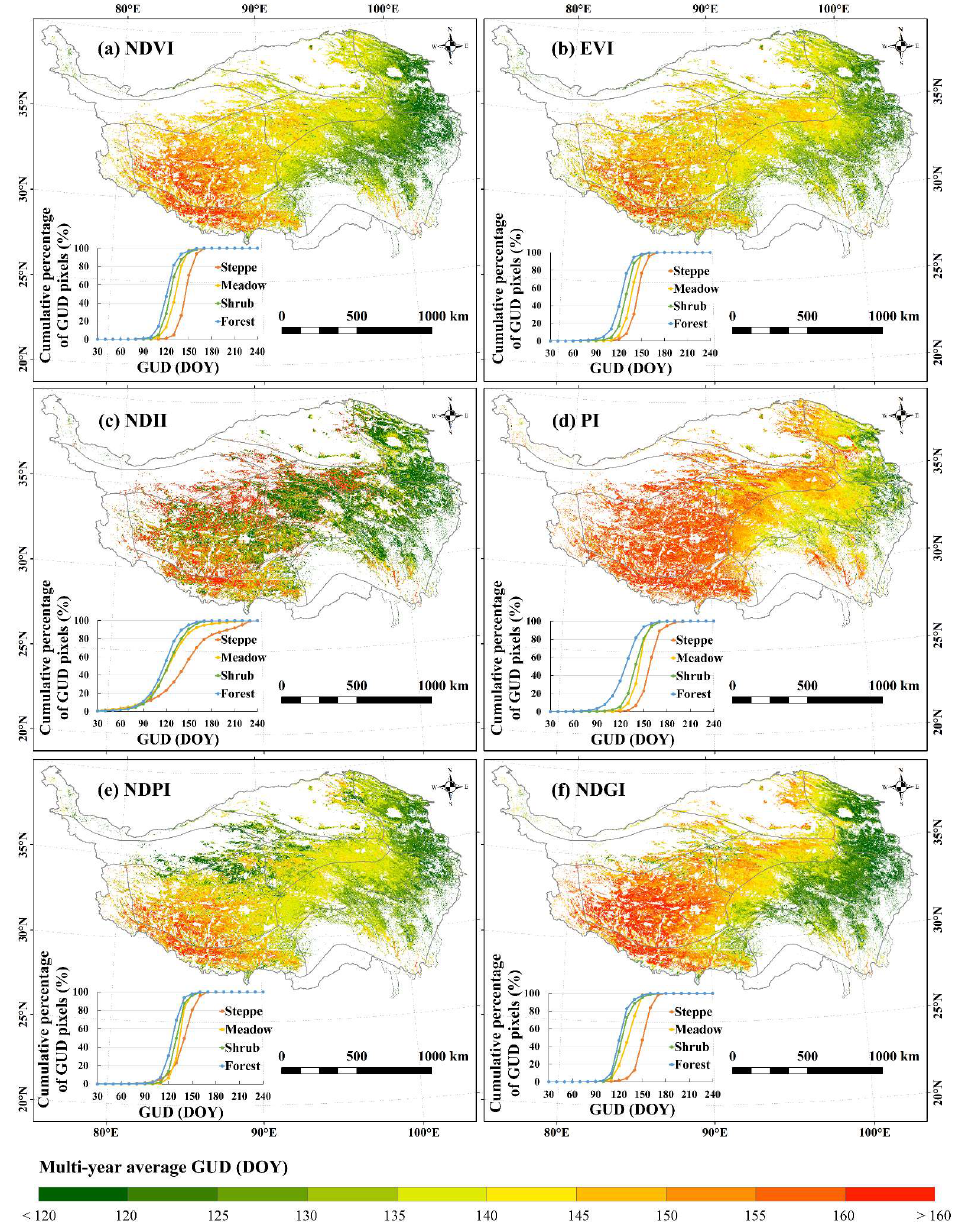
Figure 2. The spatial variation in the multi-year mean GUD during 2003–2020 derived from each of the six VIs (NDVI, EVI, NDII, PI, NDPI and NDGI) averaged over the four methods ( β max , CCR max , G20 and RC max ). The line chart in the lower left of each subgraph displays the cumulative percentage of GUD pixels for each vegetation